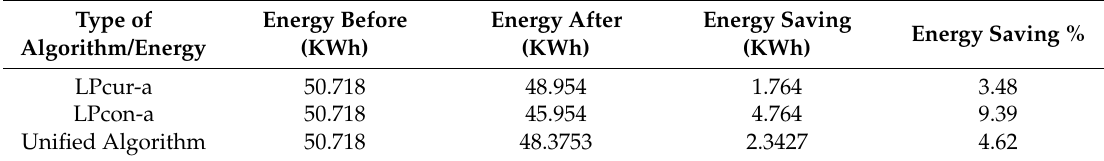
Table 5. Energy consumption under HEMS algorithms.